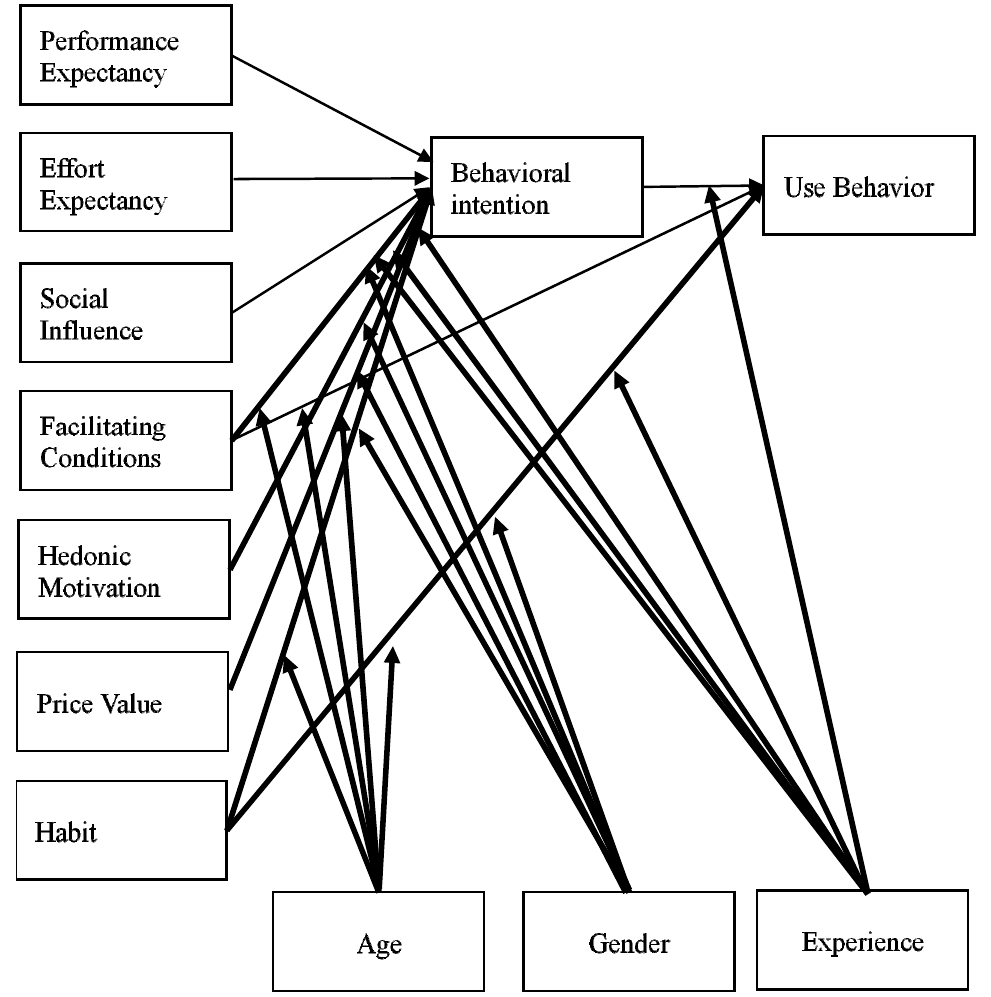
Figure 1. Extend Unified Theory of Acceptance and Use of Technology (UTAUT2) framework [24].